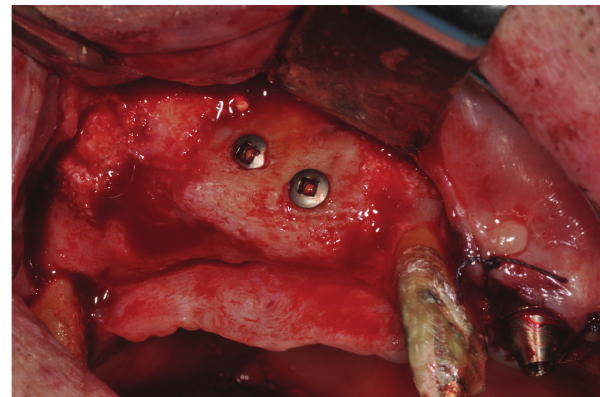
Figure 3: The surgical site is reopened.